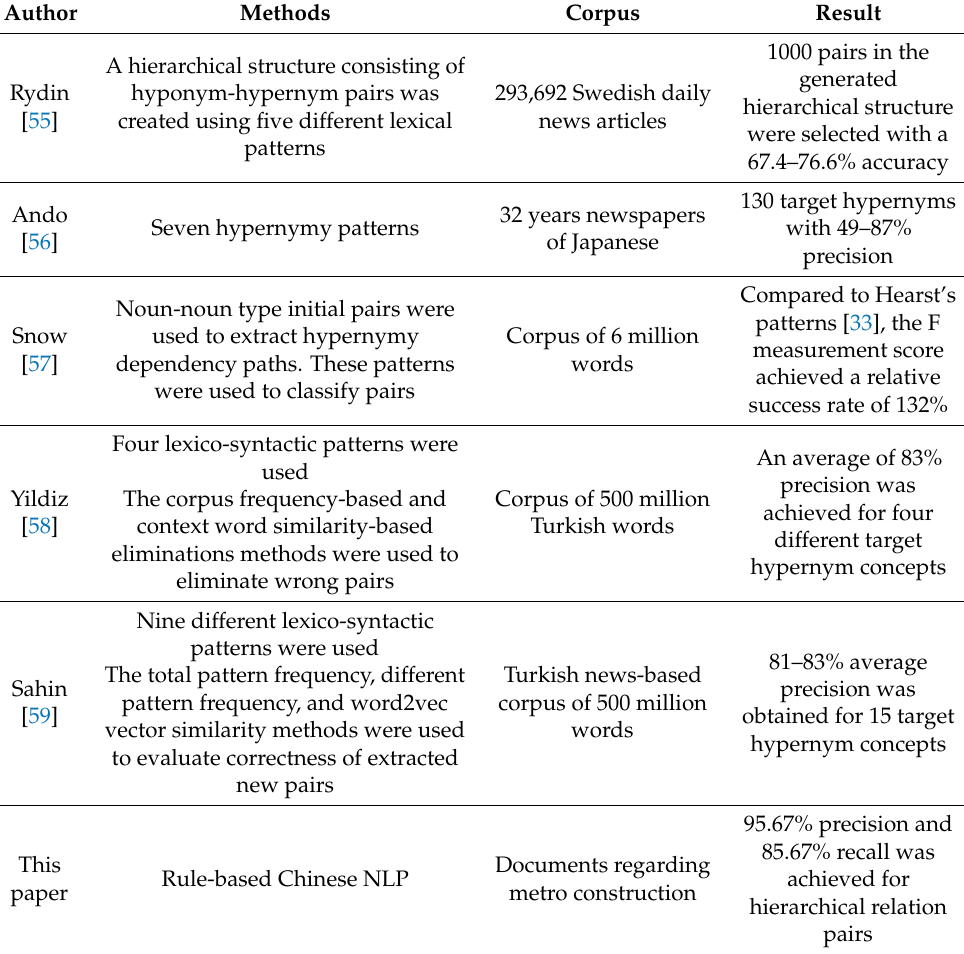
Table 6. Comparative analysis of hierarchical relation